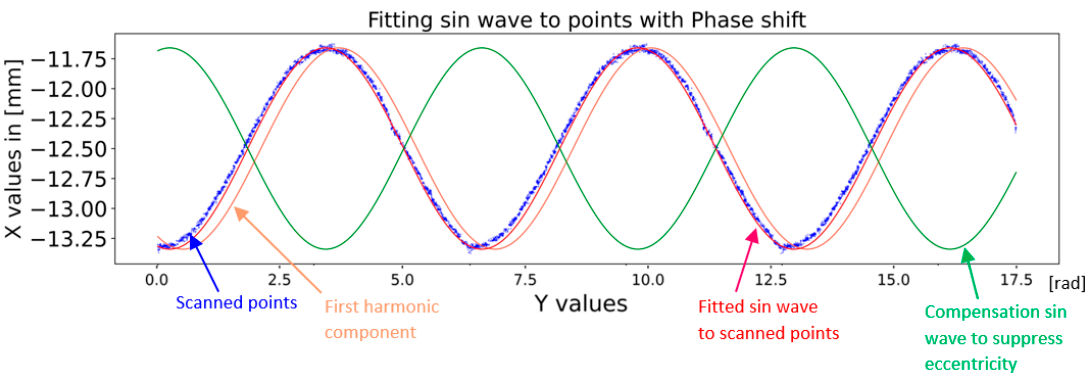
Figure 10. Fitted sine wave and compensation sine wave.